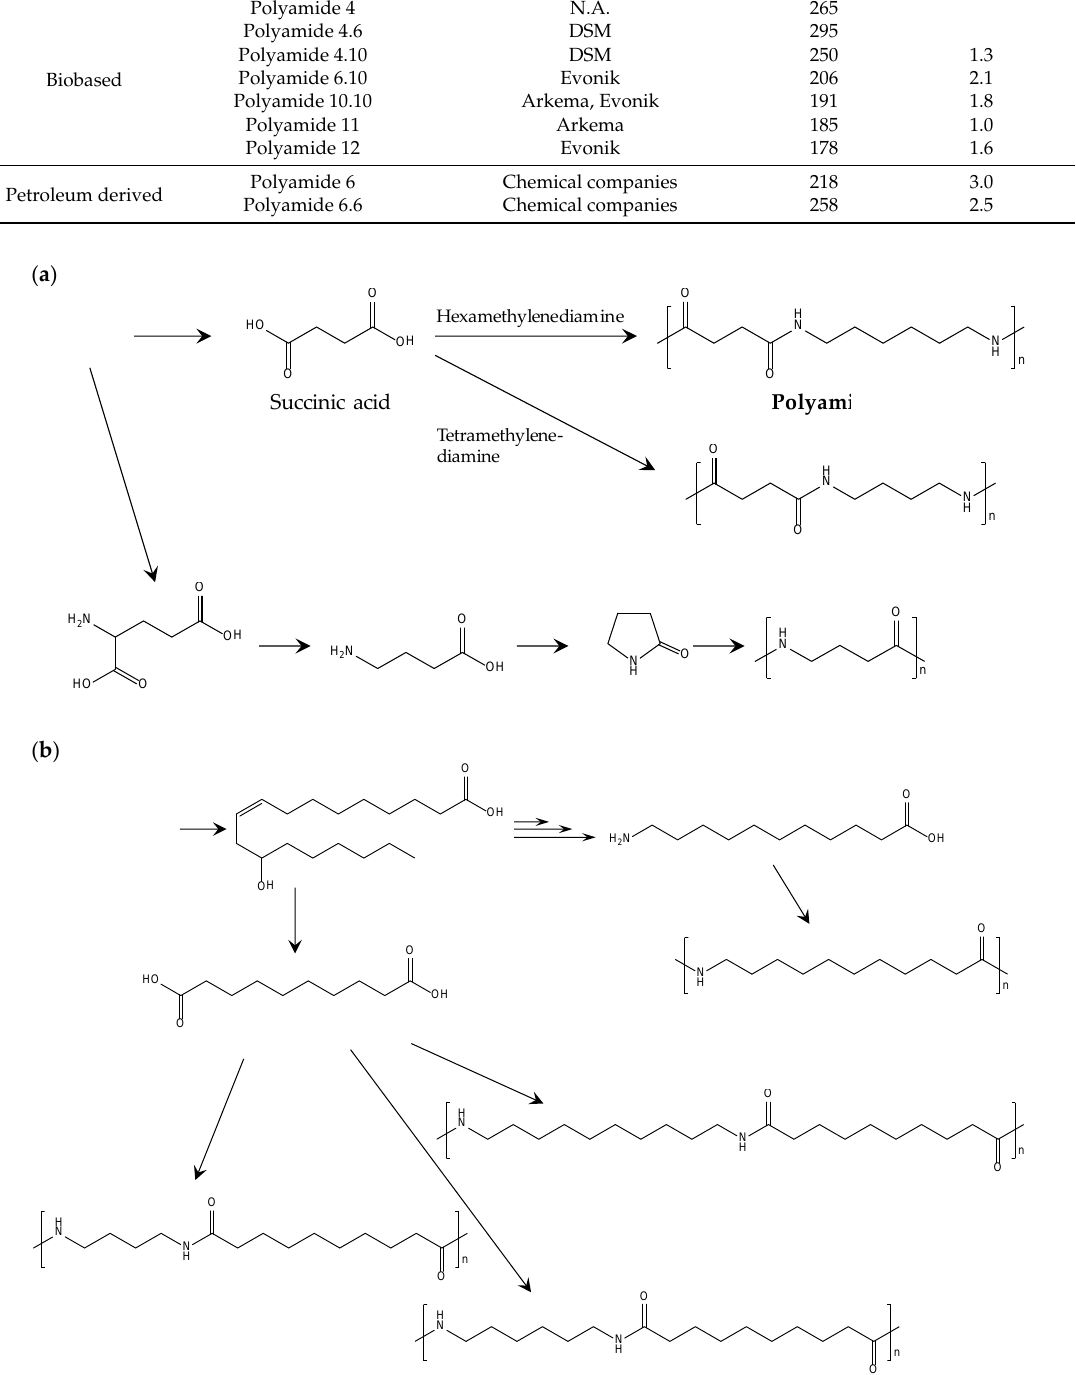
Figure 7. Method of building block production and biobased polyamide polymerization: ( a ) biobased polyamides from sugar; ( b ) from castor oil [78].